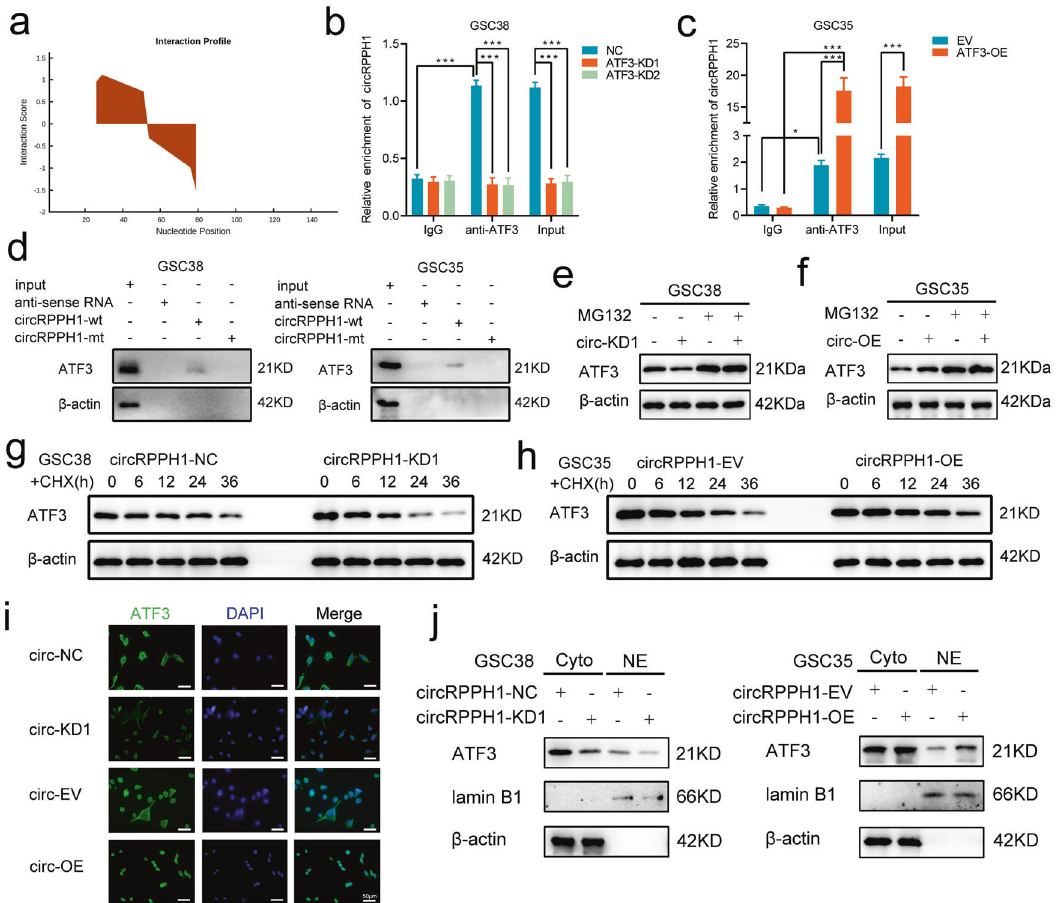
Fig. 4 CircRPPH1 can regulate the stability and the nuclear translocation of ATF3. a The CatRAPID database predicted the interaction of circRPPH1 and ATF3. b , c RNA immunoprecipitation (RIP) assays were performed in GSCs after ATF3 knockdown and overexpression. The qPCR detected the expression of circRPPH1 in each group. (GSC38: p < 0.001; GSC35: p < 0.001; Student ’ s t-test). d RNA-pulldown and western blotting revealed the interaction between circRPPH1 and ATF3 in GSCs. e , f MG132 treated GSCs under ATF3 knockdown or